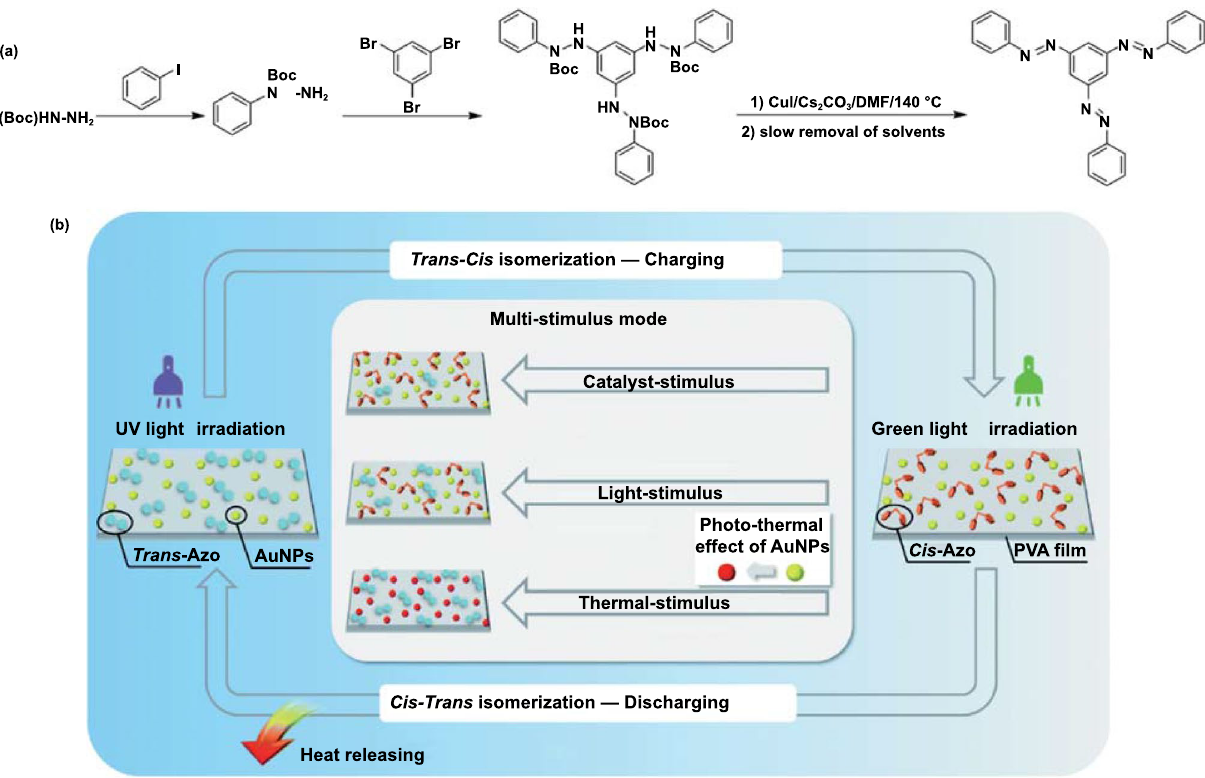
Fig. 16 a Route used to synthesize tri-azobenzene. b Schematic of the charge–discharge procedure of PVA/Azo@AuNP STF